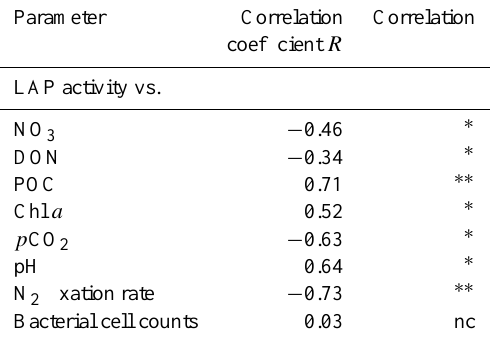
Table 4. Correlation of leucine aminopeptidase activity with biomass of filamentous cyanobacteria (POC, Chl a ), dissolved inor- ganic and organic P, p CO 2 , pH, N 2 fixation and bacterial cell counts ( n = 36, except for NO 3 , DON ( n = 35) and N 2 fixation ( n = 32); R =correlation coefficient). Correlation level is marked as ∗ for low significance (0 . 03 < | R | < 0 . 7, p < 0 . 05) as ∗∗ for strong signifi-